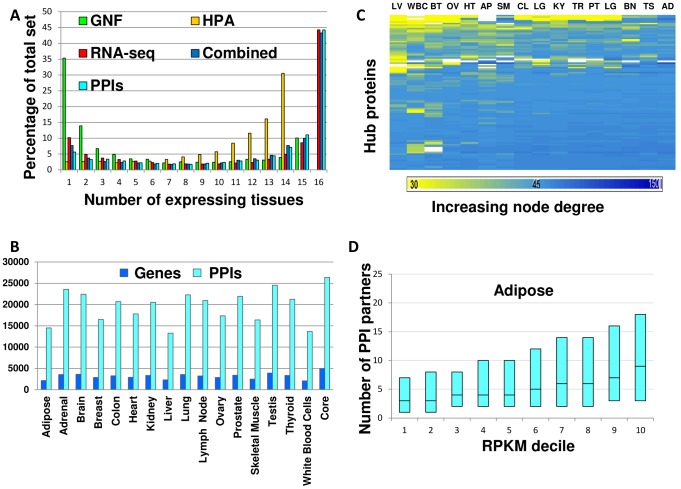
Common features of tissue interactomes.A. The distribution of proteins and PPIs by the number of tissues in which they are expressed is bi-modal, with most genes being globally expressed or tissue-specific. The distribution is shown per dataset and when combined. PPIs show a corresponding bi-modal distribution (the numbers of PPIs across 1–16 tissues appear in Table S11). B. A comparative view of the numbers of expressed proteins and PPIs across tissues. The core sub-network that is shared by all tissues (the right-most bar) is larger than the interactome of each tissue that remains after excluding the core. The numbers of genes and PPIs in the interactome of each tissue appear in Table S12. C. Most tissue hubs are widely expressed and retain their large PPI degree when expressed. The PPI degrees of the 451 tissue hubs (rows) in the 16 tissue interactomes (columns) are presented using a heat map, where each entry marks the PPI degree of the corresponding hub in that tissue. Entries are colored by the PPI degree from yellow (≤30 PPIs) to dark blue (≥150 PPIs); a white entry implies that the hub is not expressed in that tissue. Tissue acronyms: LV = Liver, WBC = White Blood Cells, BT = Breast, OV = Ovary, HT = Heart, AP = Adipose, SM = Skeletal Muscle, CL = Colon, LG = Lung, KY = Kidny, TR = Thyroid, PT = Prostate, LG = Lung, BN = Brain, TS = Testis, AD = Adrenal. D. A strong correlation between RPKM levels and PPI degree is observed in adipose tissue (Spearman r = 0.98, p = 4.7*10−7). The box-plot diagram shows the quartiles (25%, 50% and 75%) of the sorted PPI degree values in each RPKM bin. Similar correlations were observed in all 16 tissues (Figure S3).